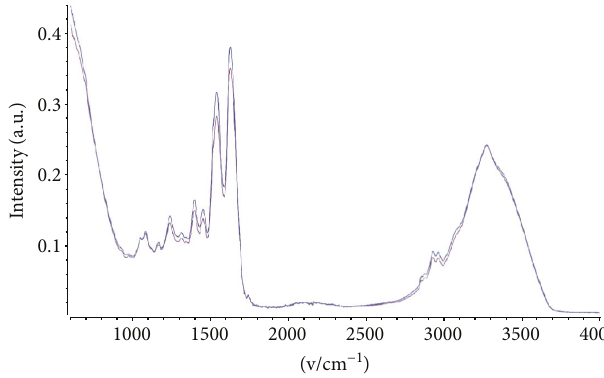
Figure 2: FT-IR spectra of fat from fresh salmon samples displaying a broad range of bandwidths.